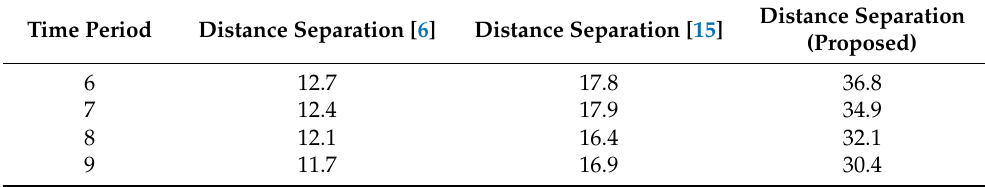
Table 3. Distance of separation vs. time